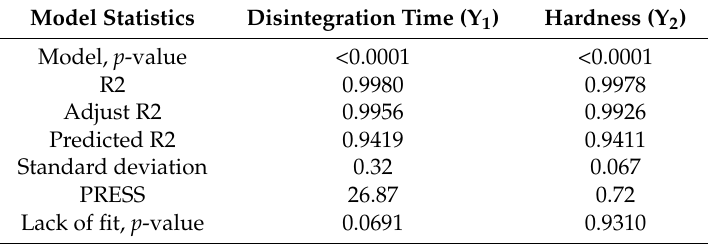
Table 6. Summary statistics for a reduced special cubic model for disintegration time and quadratic model for hardness in herbal tablets containing 65% Wuzi Yanzong dry powder